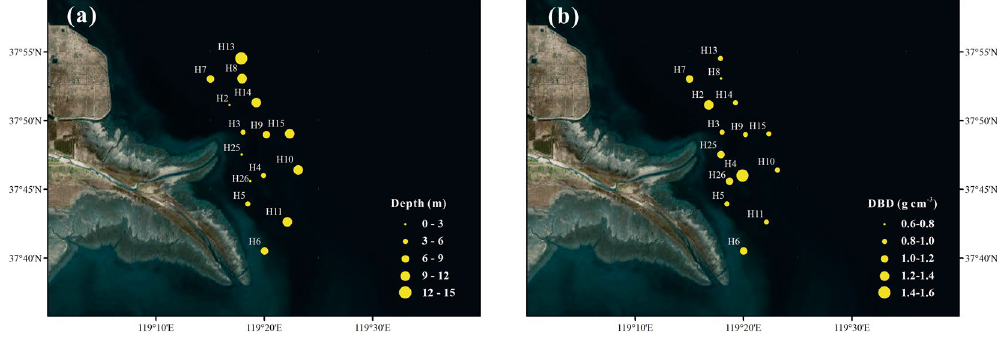
Figure 1. Spatial distributions of (a) depth (m) and (b) dry bulk density (DBD, g cm − 3 ) in surface sediments of the Yellow River Estuary. The maps were generated by ArcGIS 10.2